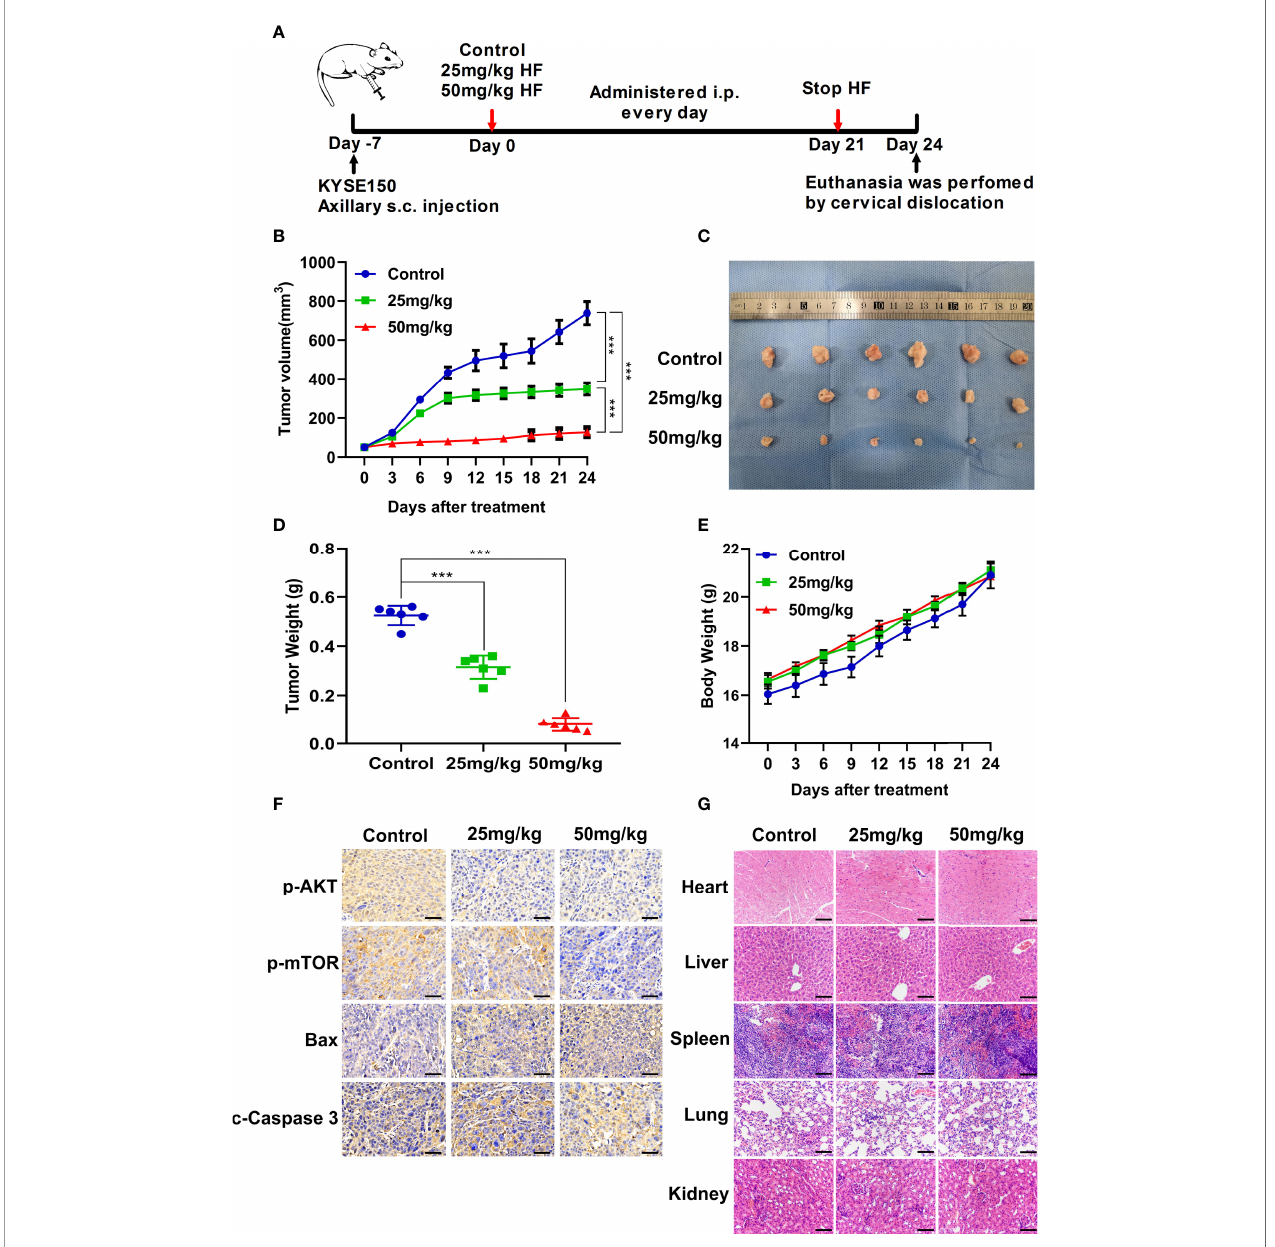
FIGURE 7 | HF suppresses the growth of mouse ESCC xenograft tumors. (A) BALB/c-nu mice implanted with KYSE150 xenograft tumors were treated daily with an equal volume of saline (control group) or HF (25 or 50 mg/kg) by intraperitoneal injection for total 21 days. (B) The tumor volume was measured every 3 days, and the difference in tumor volume between HF treated and control mice is shown. ***P < 0.001. (C) After euthanasia of mice, subcutaneous xenografts were removed and photographed. (D) The removed xenograft tumors were weighed and graphed for statistical analysis. ***P < 0.001 vs the control group. (E) Body weights of tumor-bearing mice were measured every 3 days in the HF-treated and control groups. (F) Expression levels of p-AKT, p-mTOR, Bax, and cleaved-Caspase 3 were detected by immunohistochemistry in the xenograft tumors. Magni fi cation, ×400; scale bars = 50 µm. (G) H&E staining of the heart, liver, spleen, lung, and kidney of experimental mice shows no pathological changes in the organ tissues of any group. Magni fi cation, ×200; scale bars = 100